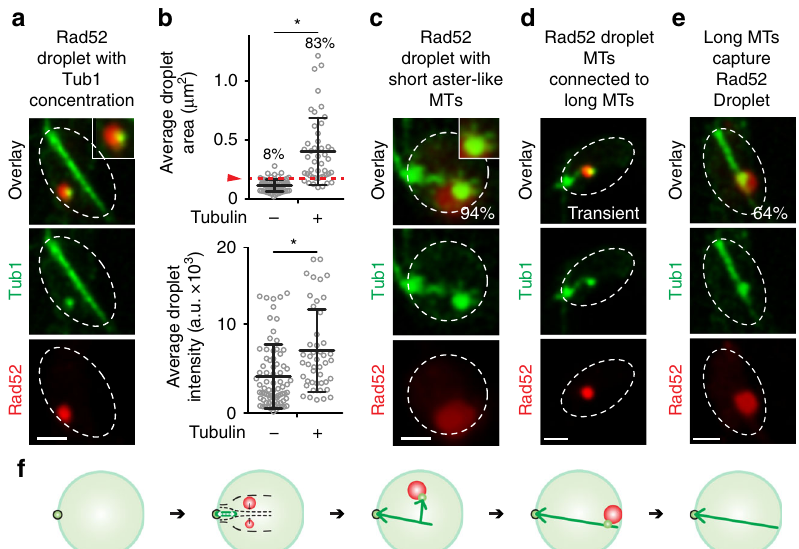
Fig. 5 Rad52 repair centre droplets concentrate tubulin and project fi laments for perinuclear DSB targeting. a , b Live-cell confocal microscopy and quanti fi cation showing that Rad52 droplets exceeding 0.2 µ m 2 in size (red line) have a 10-fold higher chance of concentrating tubulin ( n = 6, 168 droplets). c – e Tubulin foci inside Rad52 droplets project aster-DIMs ( c ) that reach the long DIM ( d ) before stable Rad52 droplet capture by the DIM ( e ). Frequency of events is shown in white. MTs microtubules. f Proposed model. Quanti fi cations represent the mean ± s.d.; * P ≤ 0.0001 in Mann – Whitney U tests. n = 77 (Tubulin-) and 46 droplets (Tubulin + ) over six independent experiments ( b ). Scale bars, 1 µ m. Source data are provided as a Source Data fi